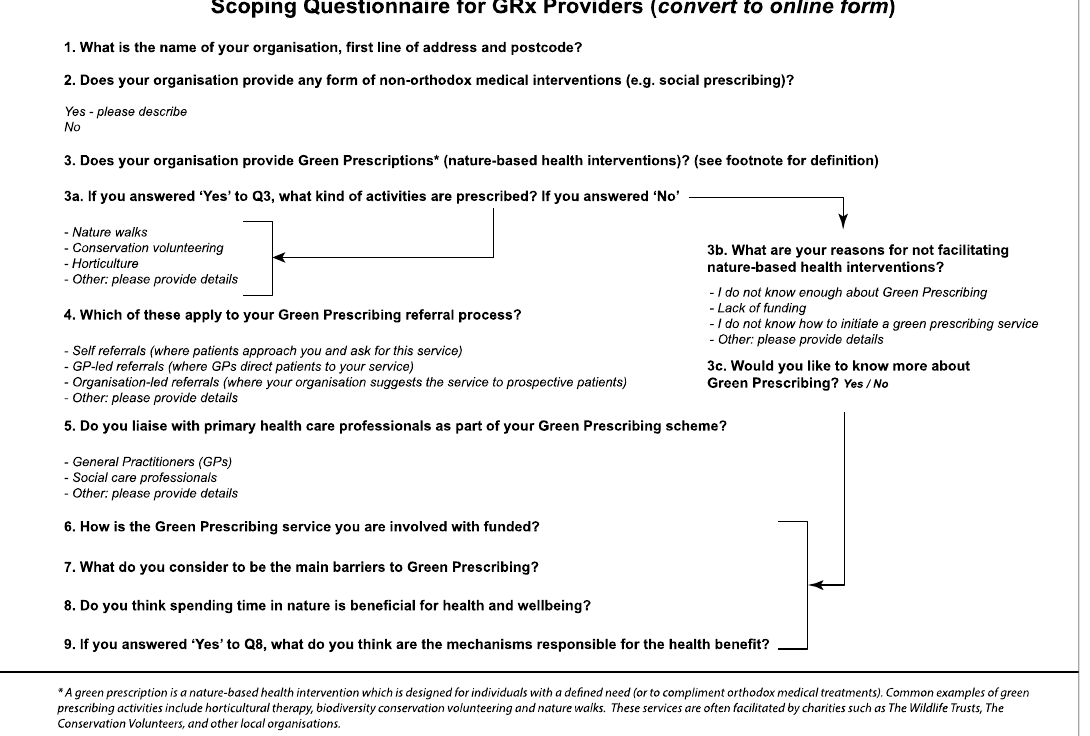
Figure A2. Green prescribing questionnaire for NBOs.